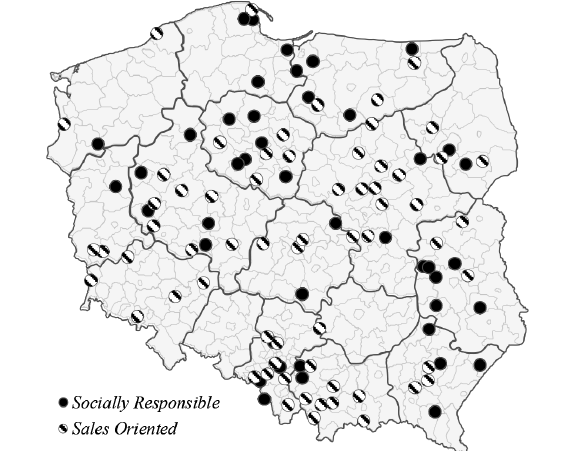
Figure 2. Geographical distribution of head offices of SLBs following the two represented Facebook activity models (source: author’s own